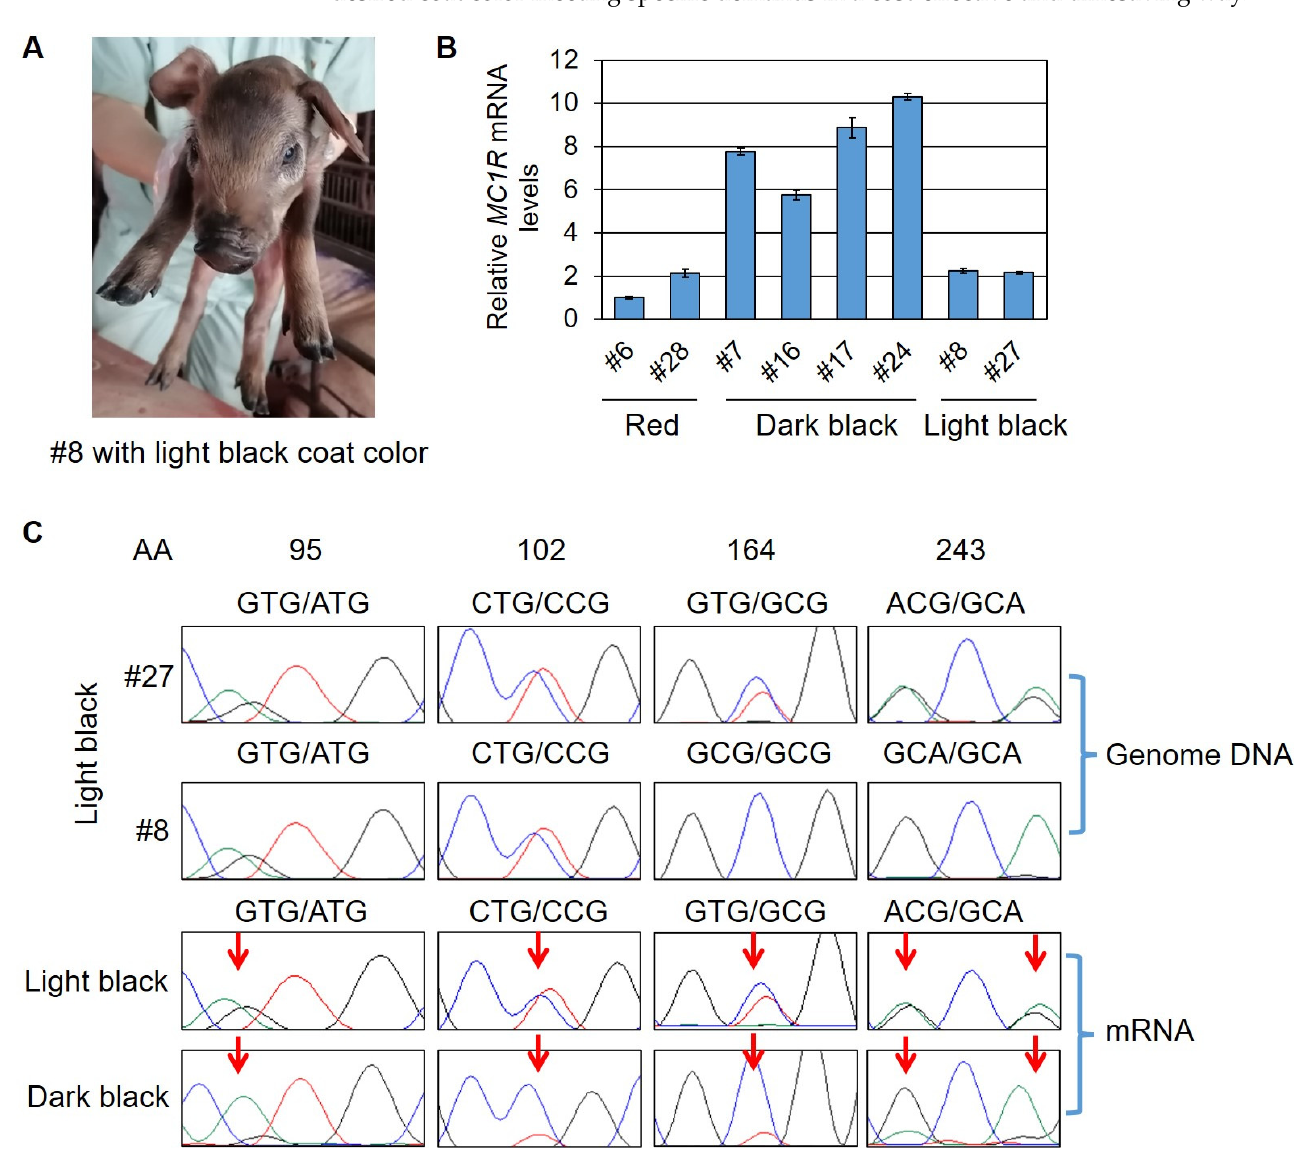
Figure 3. Analysis of MC1R gene of cloned Durocs with light black coat color. ( A ) Representative image of a cloned Duroc (#8) showing the light black coat color. ( B ) Quantification of MC1R mRNA level in ear skin among cloned Durocs with three different coat colors (red, dark black, and light black). ( C ) Sanger sequencing results of genome DNA showed that #27 had the heterozygous E D1 /e alleles, and #8 had the heterozygous E D1 /E + alleles (one allele of MC1R was changed to E D1 genotype and the other allele had a V164A substitution forming an E + genotype). Sanger sequencing of cDNA showed an equal expression level for both E alleles in light black pigs, but a great higher expression for the E D1 allele in dark black pigs. Red arrows point to SNP sites varied in E D1 and e alleles. AA, amino acid position.